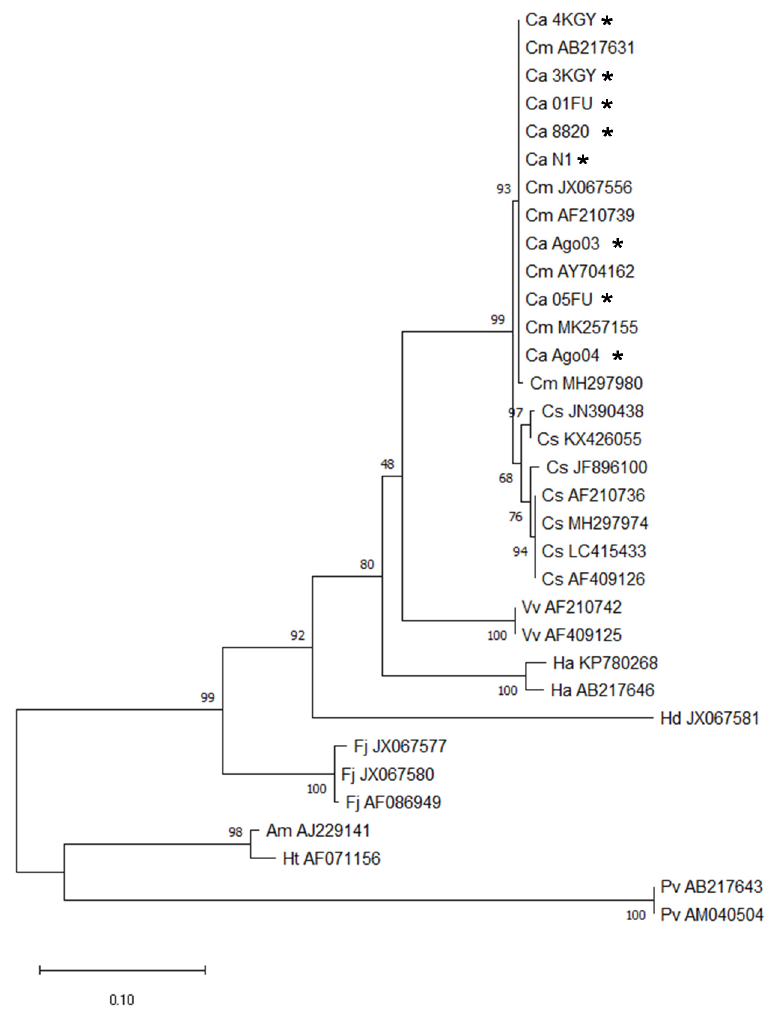
Figure 1. Maximum-likelihood phylogenetic tree from partial sequences of the large subunit (LSU) D1–D2 regions in rDNA of Chattonella marina complex strains. The tree was inferred from the K2 + G model. The accession numbers or strain ID used in the present study (asterisks) are shown following the species name. Numbers on the major nodes present maximum-likelihood bootstrap values (1000 replicates). The tree was rooted using Ascoseira mirabilis , Halosiphon tomentosus , and Psuedochattonella verruculosa as the outgroup. Abbreviations of scientific names are as follows: Ca, Chattonella antiqua